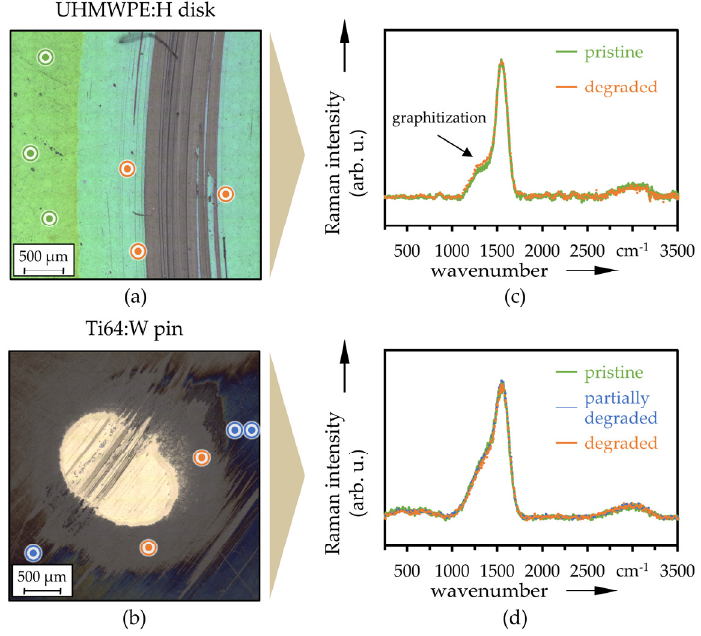
Figure 12. LM images with Raman measurement positions on the disk ( a ) and pin ( b ) as well as averaged Raman spectra ( n = 3) at pristine, partially degraded and degraded positions of UHMWPE:H ( c ) and Ti64:W ( d ).